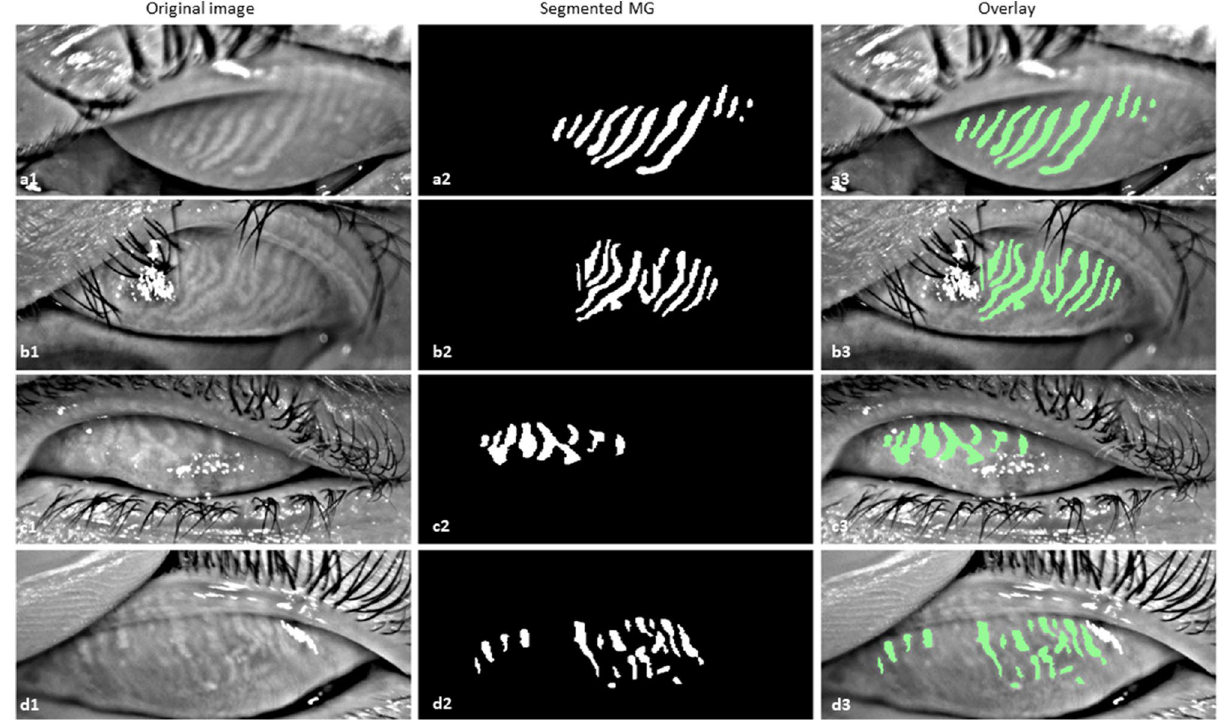
Figure 8. Example of MG segmentation on inferior quality images. ( a1 – a3 ) Out of focus image, segmented MGs, and overlay, ( b1 – b3 ) Eyelashes in the glands area image, segmented MGs, and overlay, ( c1 – c3 ) Partially everted upper eyelid image, segmented MGs, and overlay, and ( d1 – d3 ) Artifact of everting finger in the top left of the image, segmented MGs, and